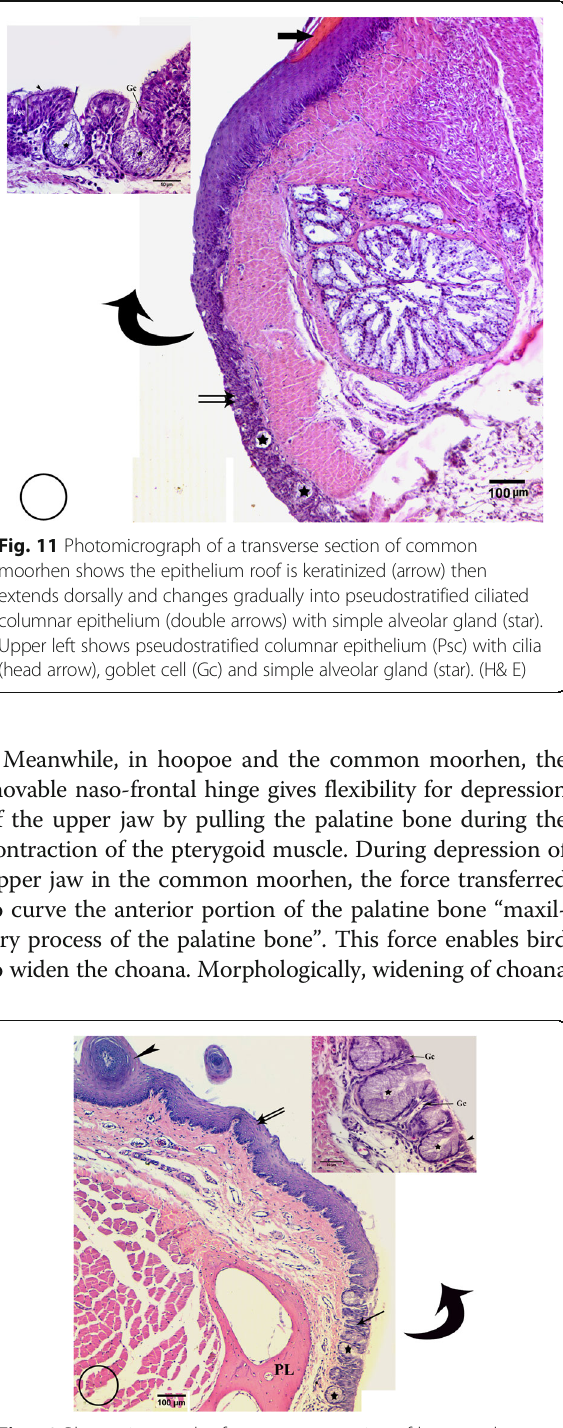
Fig. 10 Photomicrograph of a transverse section of kestrel shows the epithelium roof is keratinized (double arrows) which covers the choanal ridges (Chr), then extends dorsally and changes gradually into pseudostratified ciliated columnar epithelium (arrow). Upper left shows pseudostratified columnar epithelium (Psc) with cilia (head arrow), goblet cell (Gc), and simple alveolar gland (star). (H& E)